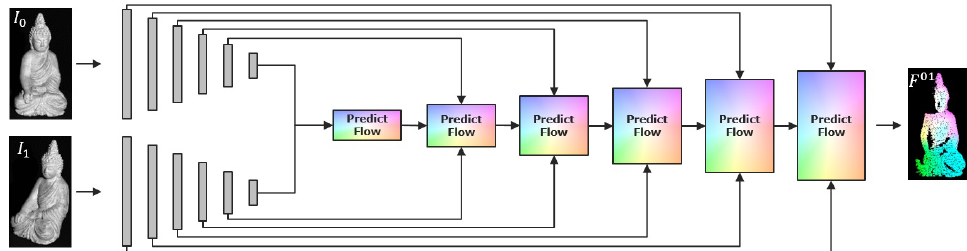
Figure 4. Sketch of the PWC-Net architecture. The input is convolved through multiple layers and the optical flow is predicted starting from the lowest level upwards in a U-Net structure. In each level, the layers of I 1 are warped towards the layers of I 0 in order to provide initial flows from previous lower levels. With this pyramidal approach, large flows are also predictable with quite small filter